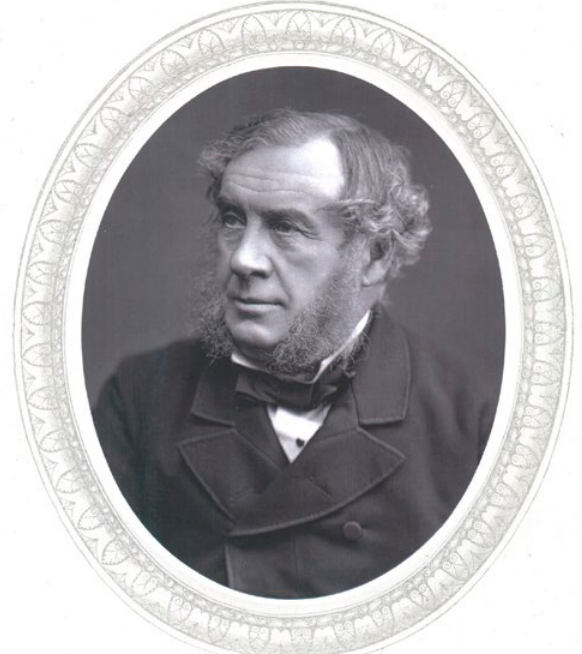
Figure 2. Portrait of William Robert Grove. Woodburytype by Lock and Whitfield. Smithsonian Institution Libraries.